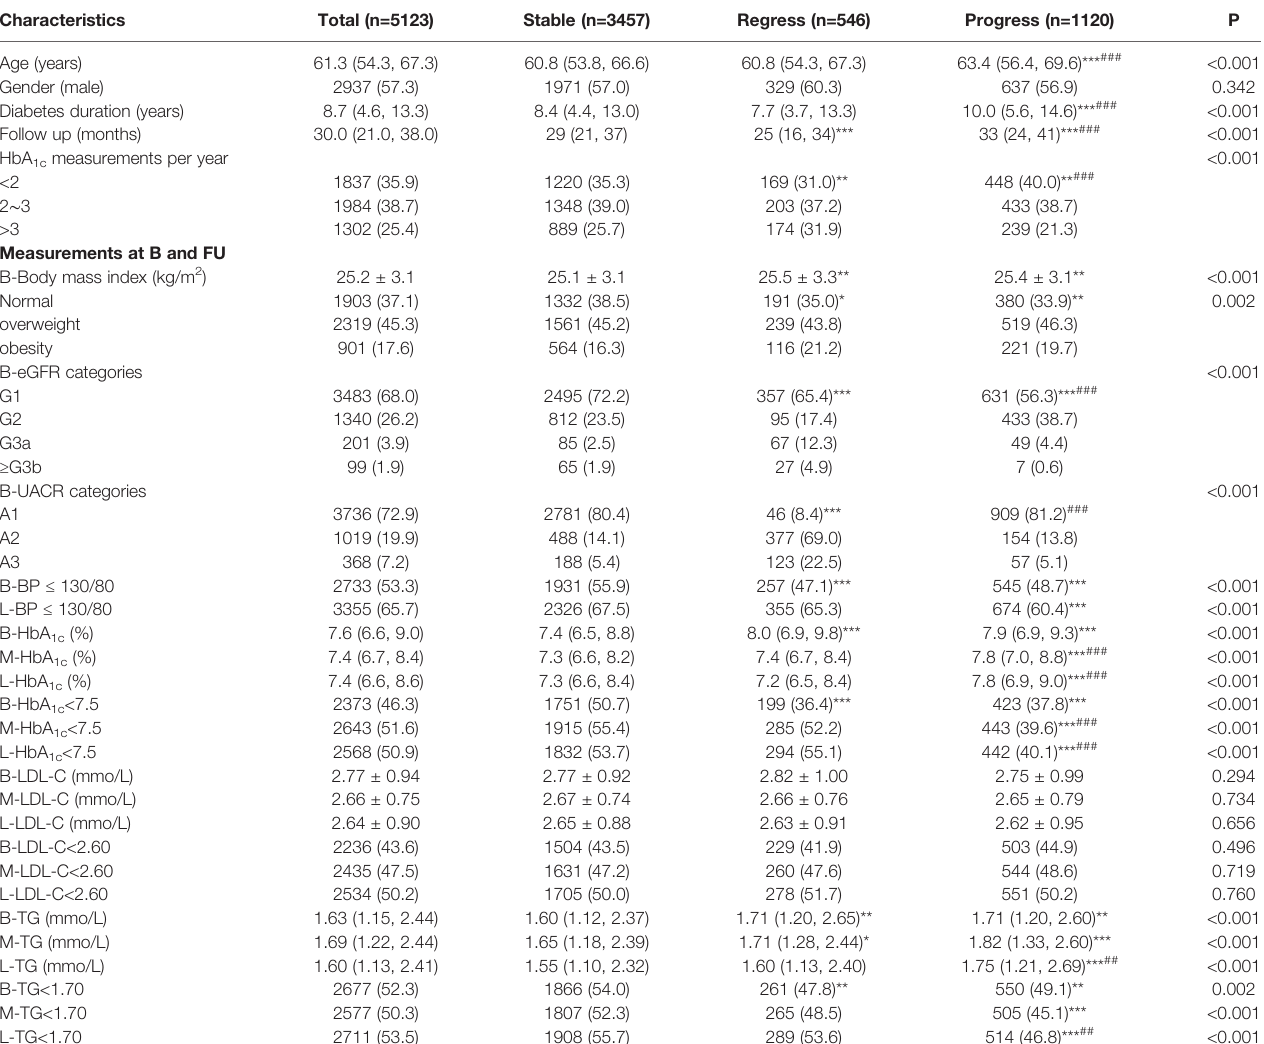
TABLE 3 | Characteristics of study population by CKD outcome. Characteristics